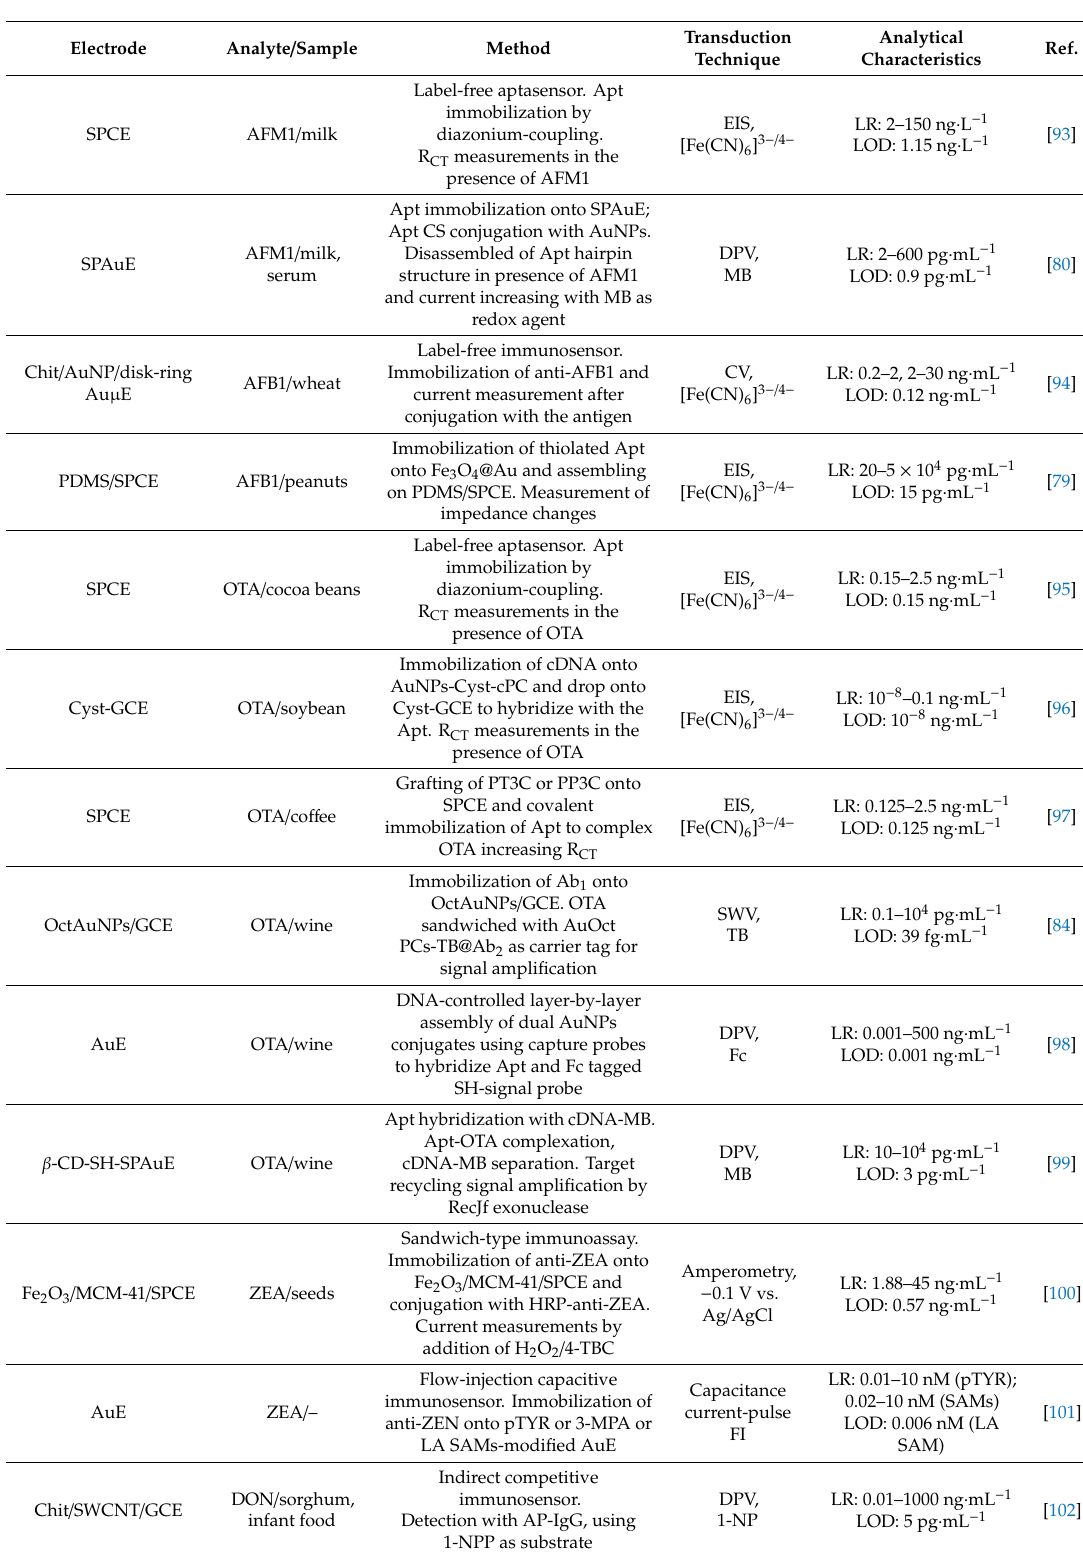
Table 3. Electrochemical biosensors for the determination of